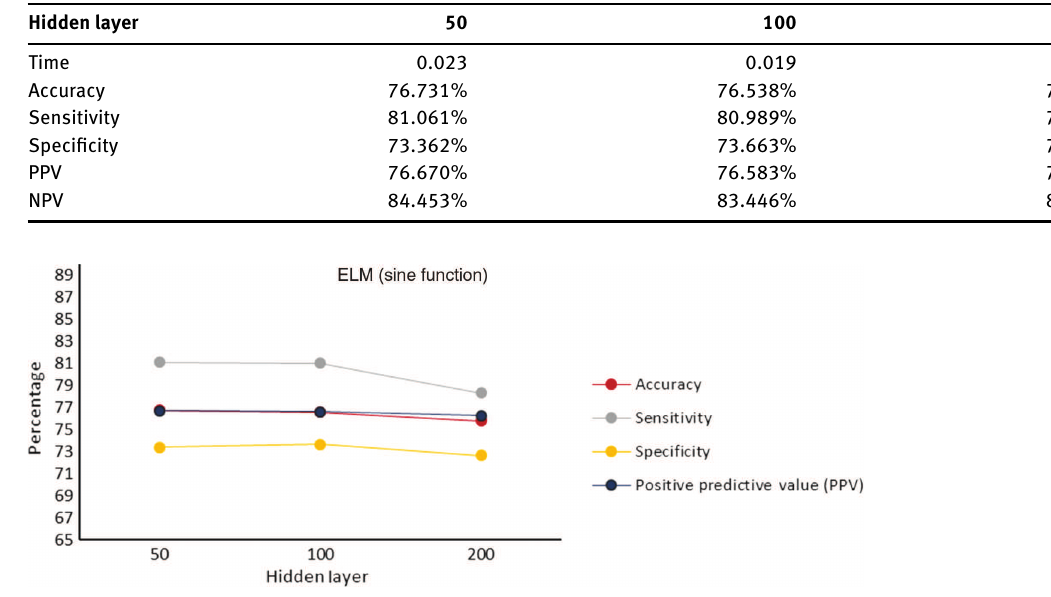
Figure 6: ELM Statistical Performance Measures Plotting (Sine